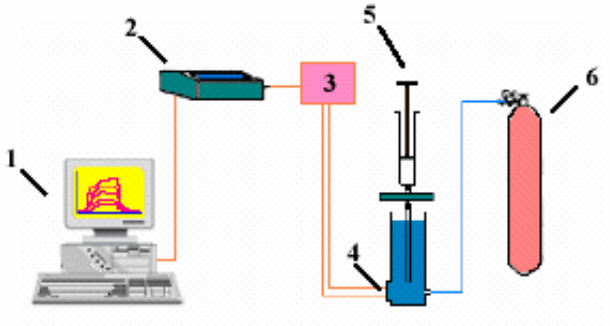
Figure 1. Schematic diagram of the experimental set-up for QCN sensor. 1. PC, 2. Frequency